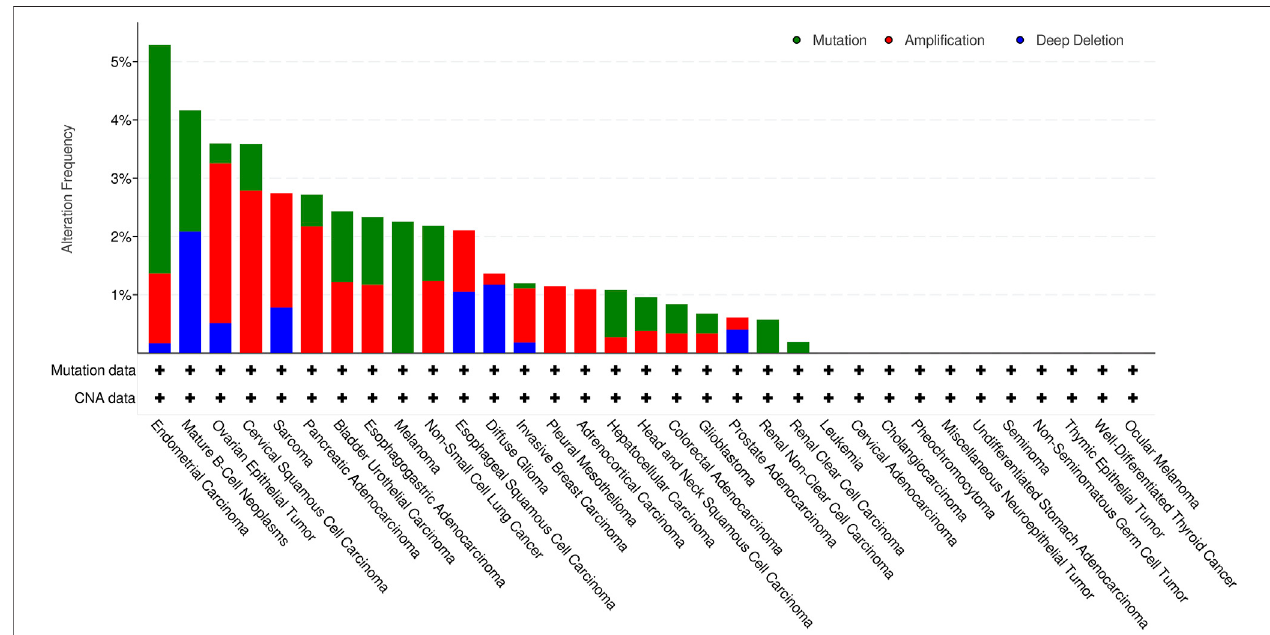
FIGURE 3 | Alteration frequency of varying types of KCNN4